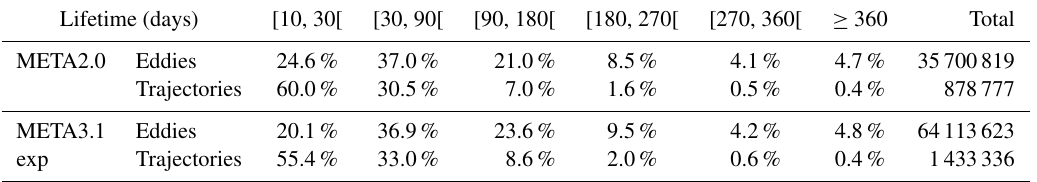
Table 3. Number of individual eddies and trajectories for different lifetimes in the META2.0 and META3.1exp products. Note that the online META2.0 product only contains eddies associated with trajectories lasting more than